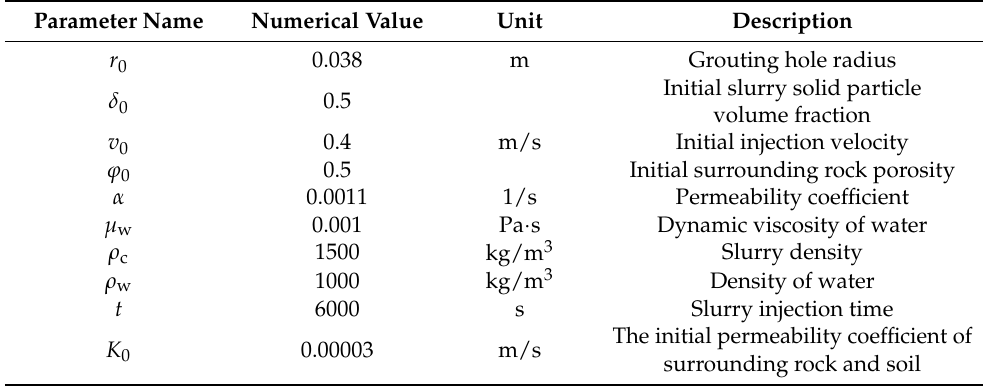
Table 1. Constant parameters used in the model.